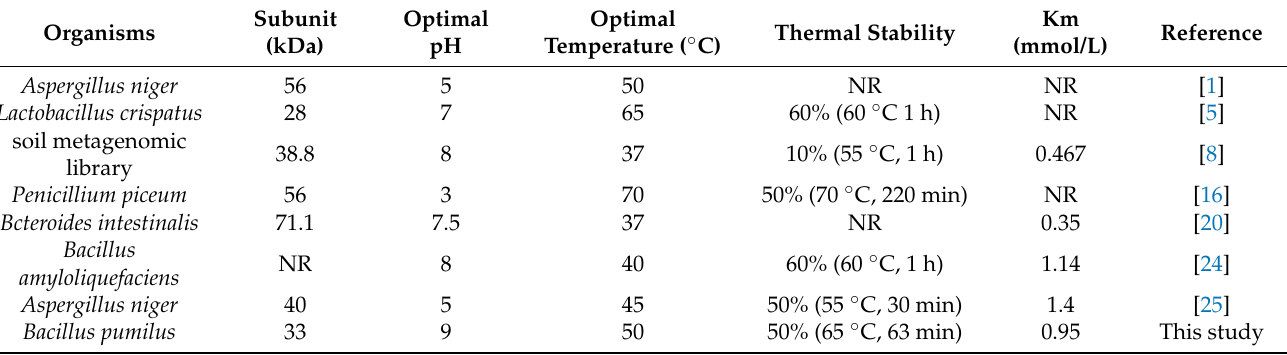
Table 2. Comparison of properties of different FAEs.